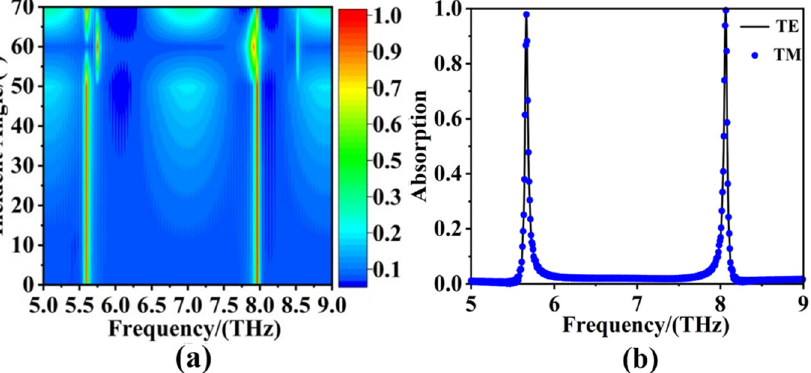
Figure 6. With the incident angle of the source increasing from 0° to 70°, ( a ) the sweep spectra of the absorber under TE and TM polarization. ( b ) the fitted spectrograms of TE and TM polarization.